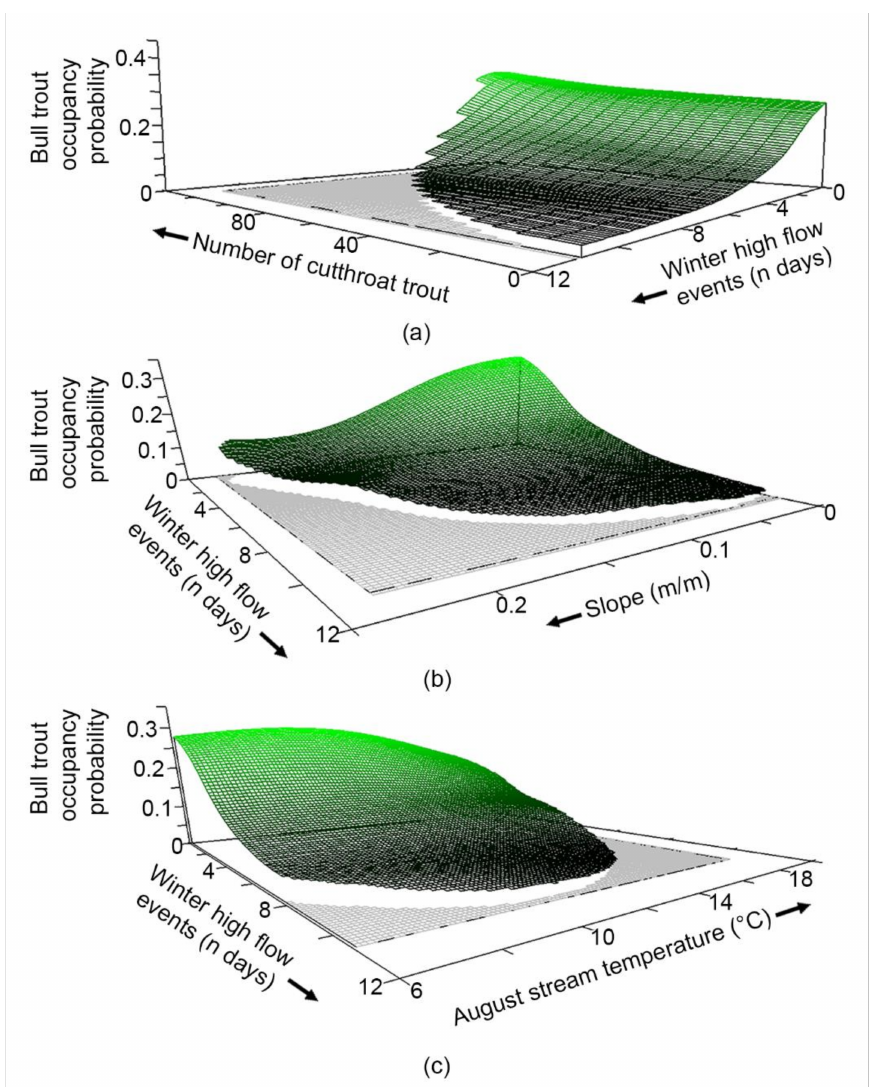
Figure 4. NPMR modeled relationships between bull trout occupancy rate (vertical axes) and ( a ) number of cutthroat trout detected in the stream reach and winter high flow events (number of winter days when stream flows are in >95 percentile of the flow of record), ( b ) winter high flow events and stream reach slope, and ( c ) winter high flow events and stream temperature in August. This model was developed from 2829 sites sampled within the ranges of the Rocky Mountain tailed frog and bull trout. Gray shading in each panel indicates regions of predictor space with insufficient data for predictions to be